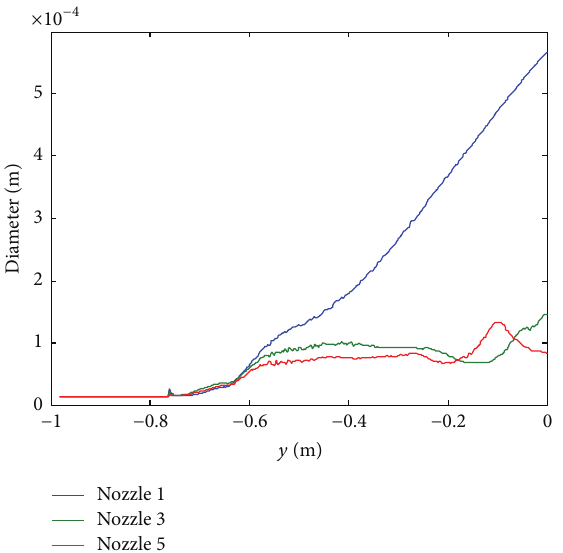
Figure 23: Plot of the diameter of bubble.